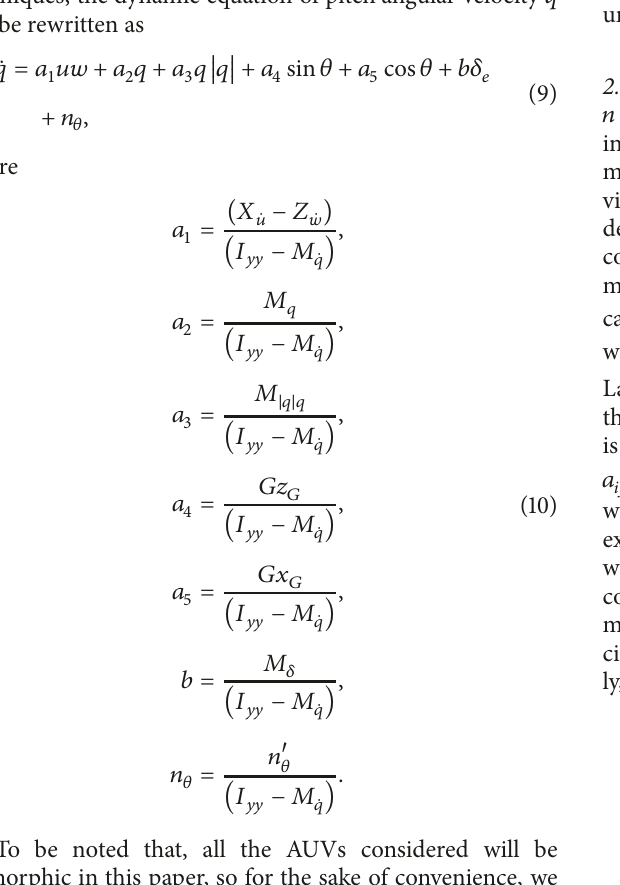
assumed that 𝑛 𝜃𝑖 ≤ 𝑛 𝑖 , where 𝑁 = [𝑛 0 , 𝑛 1 , ⋅ ⋅ ⋅ , 𝑛 𝑛 ]